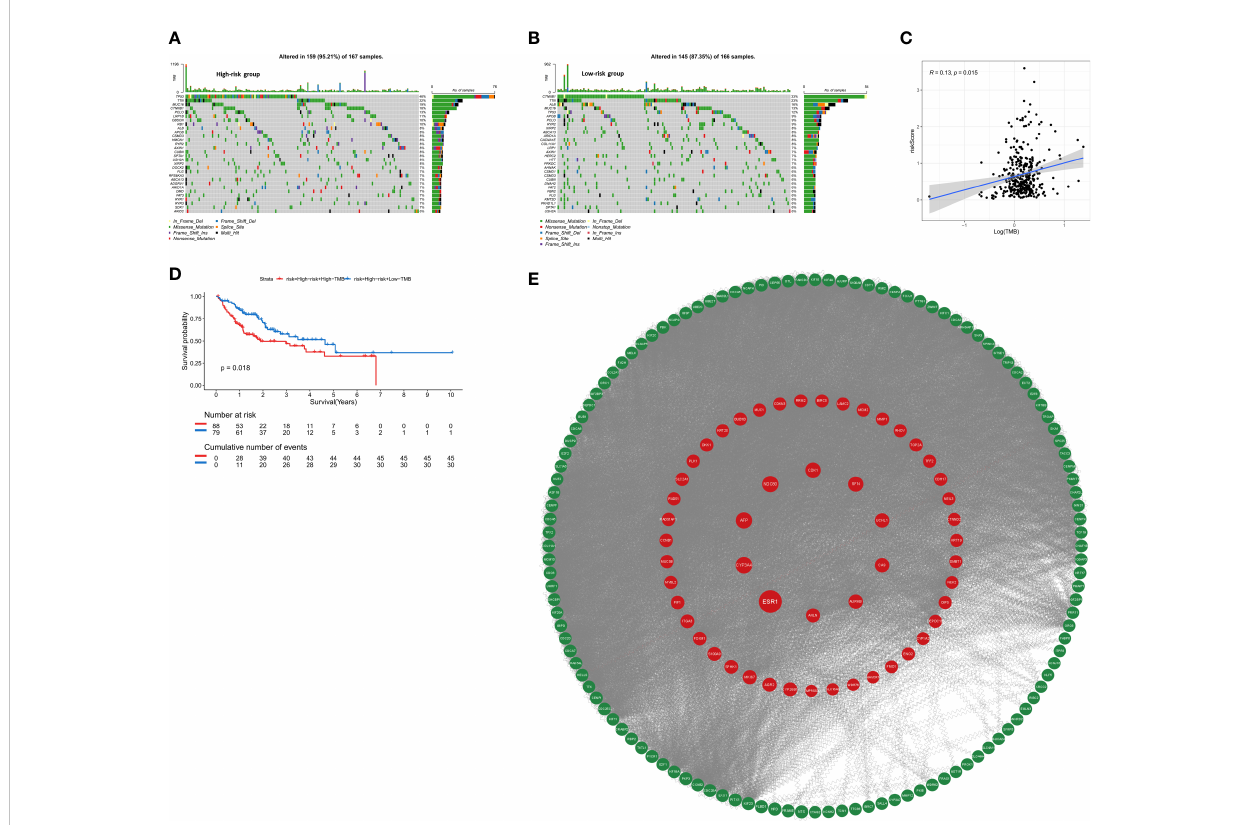
FIGURE 8 The mutation pro fi le and TMB among low-risk and high-risk groups. (A) Mutation pro fi le in the high-risk group. (B) Mutation pro fi le in the low-risk group. (C) The relationship between the anoikis-related risk signature and TMB. (D) Kaplan – Meier curves for HCC patients strati fi ed by TMB in high- risk group. (E) PPI network construction and top ten hub genes